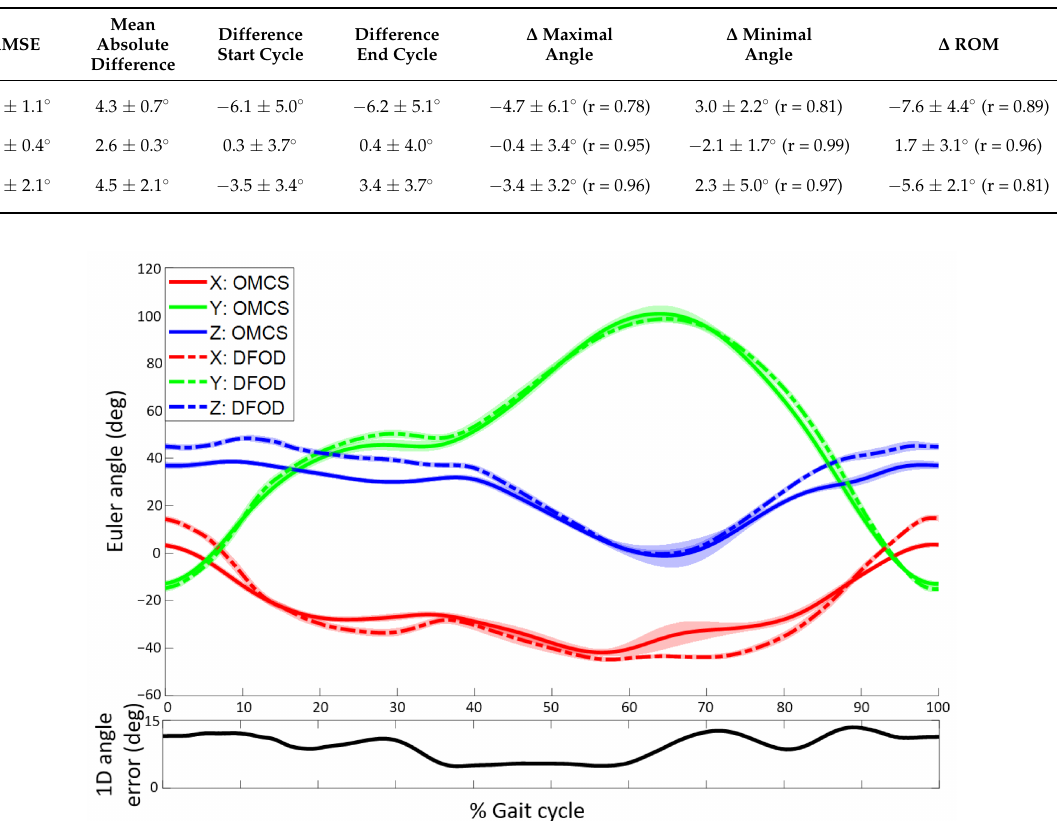
Table 1. Mean orientation differences between DFOD and OMCS for all subjects combined. RMSE refers to the root mean square difference in 3D orientation. “Difference start cycle” and “Difference end cycle” refer to the difference between DFOD and OCMS (OMCS-DFOD) at the first and last sample of the gait cycle. “ ∆ Maximal angle” and “ ∆ Minimal angle” refer to the differences in the estimated maximal and minimal orientation during each gait cycle between DFOD and OMCS (OMCS-DFOD). “ ∆ ROM” refers to the mean differences in the estimated range of motion during each gait cycle for DFOD and OMCS. Pearson correlation coefficients (r) are provided between brackets.